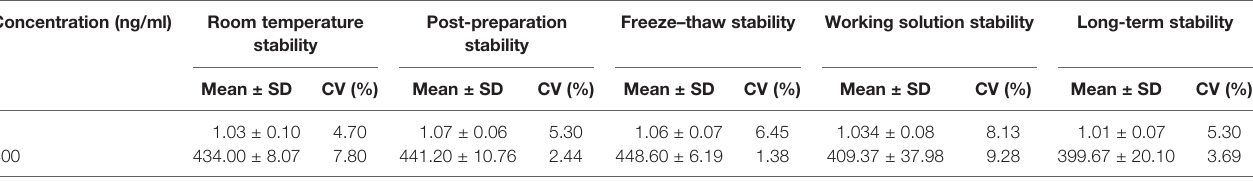
TABLE 3 | Stability of sotorasib under different storage conditions ( n = 6). Concentration (ng/ml)